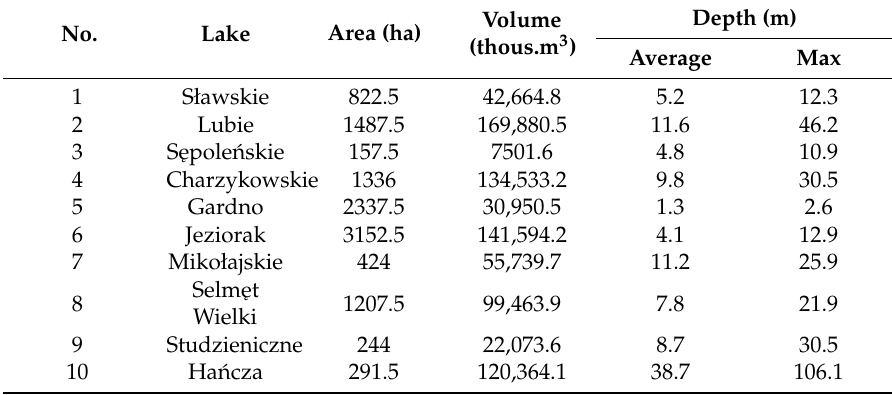
Table 1. Morphometric data of the studied